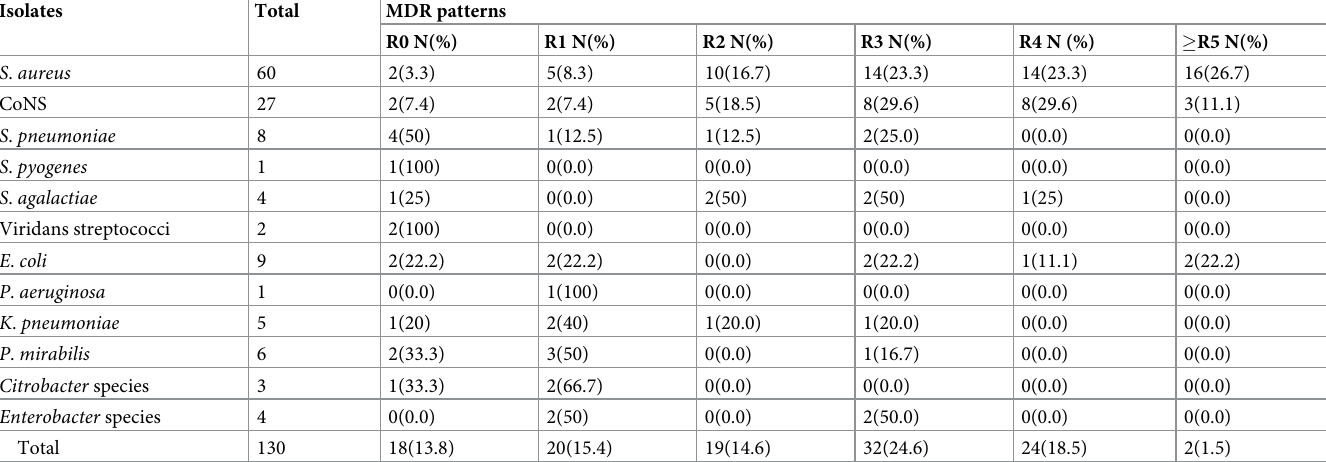
Table 5. Multidrug resistance patterns of culture-confirmed bacterial isolates from EOI patients at DMCSH, Northwest Ethiopia, 2021.